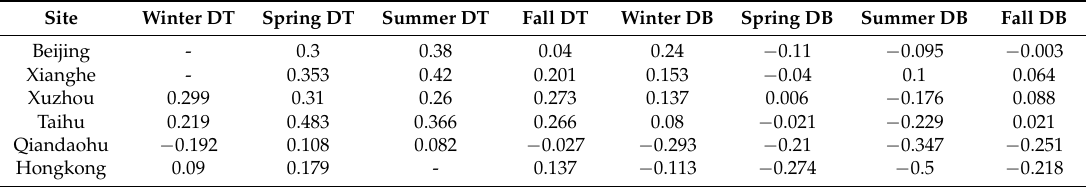
Table 2. List of seasonal mean aerosol optical depth (AOD) biases for MODIS DT and DB retrievals when AERONET AOD 550 >0.4 of eastern China. Samples with available values of no more than five were removed to be representative.